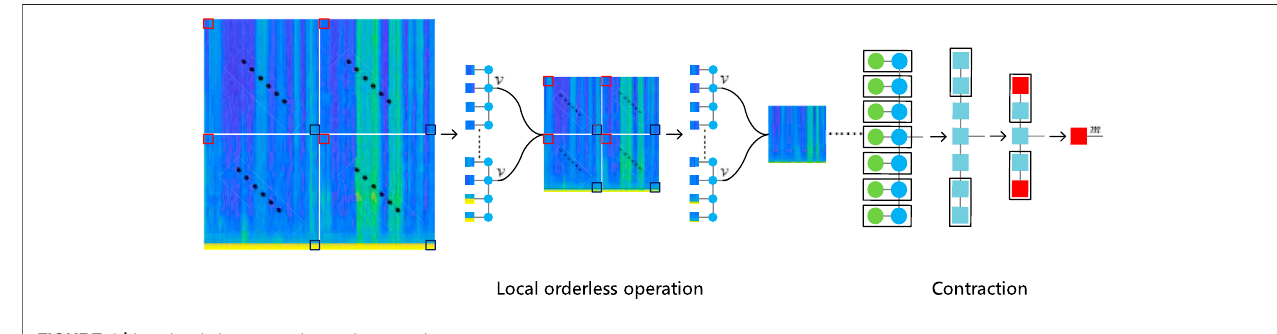
FIGURE 4 | Local orderless operation and